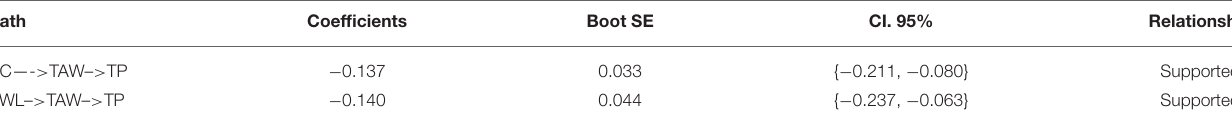
Supported { − 0.237, −